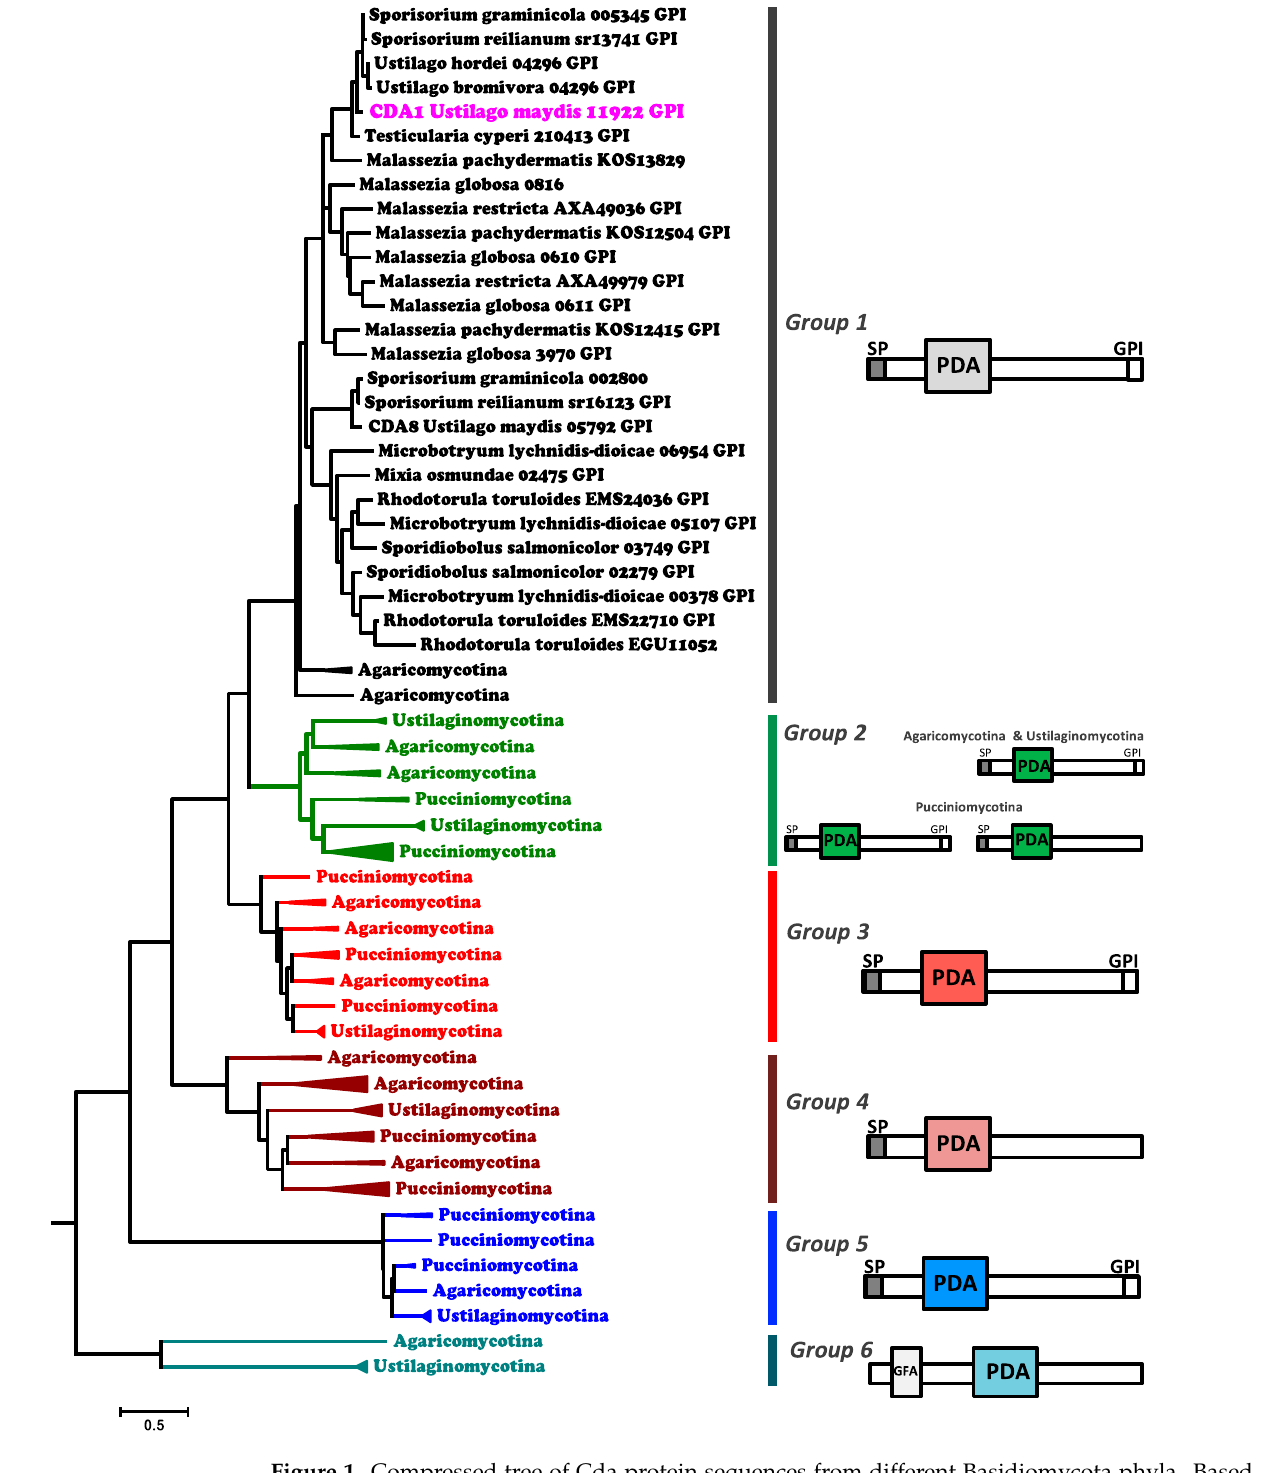
Figure 1. Compressed tree of Cda protein sequences from different Basidiomycota phyla. Based on 125 Cda sequences, the alignment was performed with MAFFT. The phylogenetic tree was reconstructed and compressed in MEGA7 and rooted with MAD. Most clades are collapsed, with the exception of group1, where Cda1 is present. The uncompressed tree is available in Supplementary Figure S2. On the right are schematic representations showing the organization of the domains in the Cda protein sequences. GFA , glutathione-dependent formaldehyde-activating; GPI , glycosil-phosphatidylinositol; PDA , polysaccharide deacetylase; SP , signal peptide.